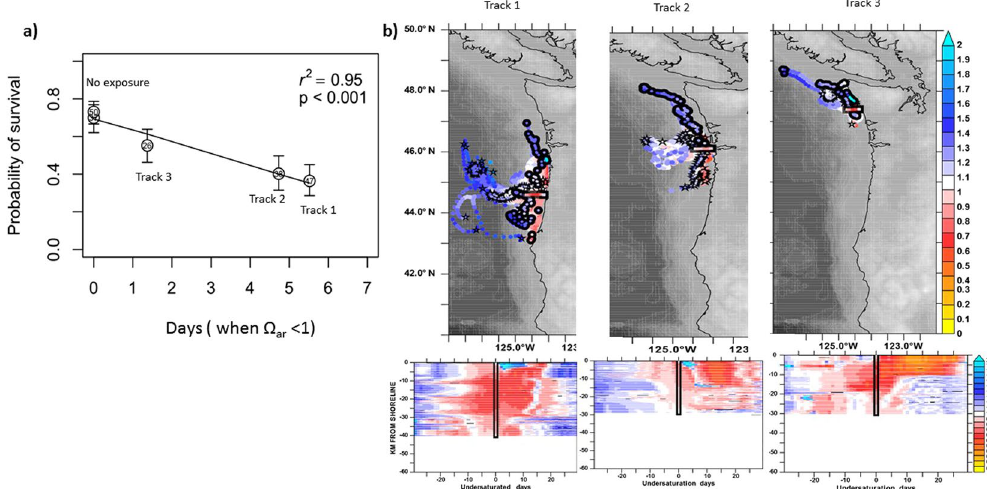
Figure 3. Exposure history to low Ω ar in the natural environment and its impact on the probability of survival. ( a ) Survival probability was determined by taking into account pteropod exposure history over the last 5–6 weeks in the CCE, based on the model outputs ( b ). The survival probability was highest at the offshore stations with no exposure history (stations 37, 50, and 106), followed by a decline at stations of “moderate” exposure (undersaturation days of ~1.5 at stations 26 and 28; exposure conditions represented on Track 3), and the lowest survival probability at the most severe exposures (undersaturation days of ~5 for stations 47 and 38; exposure conditions represented on Tracks 1 and 2, respectively). Station number is shown inside each circle. Tracks not shown for the offshore station. ( b ) Daily averaged spatial tracks and time history of aragonite saturation state for modeled particles released 1 August 2013 along cross-shelf lines spanning 126.0°W to 123.5°W, and tracked both forward and backward in time to span 1 July–31 August 2013. Particle tracking includes vertical migration of particles between 10 and 100 m. For each track we show the instantaneous values of aragonite saturation state (indicated by shading); these are further illustrated by the Hovmöller diagrams of saturation history for all tracked particles as a function of days since 1 August 2013 (x-axis) and their cross-shelf location on the release date (y-axis). Track 1 (station 47) covers a cross-shelf line near Heceta Head (44.6°N) and Track 2 (station 38) covers a cross-shelf line off Columbia River (46.2°N); both tracks are characterized by severe exposure (0.6 ≤ Ω ar ≤ 0.8) for approximately 3–4 weeks). Track 3 (stations 26 and 28) was released just off 47.7°N with exposure to less severe conditions (0.8 ≤ Ω ar ≤ 1) for approximately 2 weeks. Circles indicate start locations of a representative subsample of the tracks on 1 July 2013; rectangles indicate their location on 1 August 2013; stars indicate their end locations on 30 August 2013. The figure was created using Ferret version 6 (http://www.ferret.